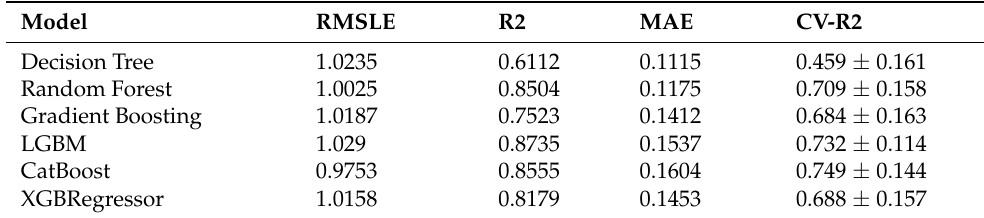
Table 6. Results of severity for the left shoulder.